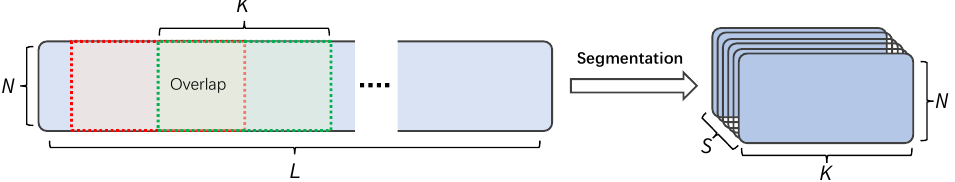
Figure 5. Feature segmentation